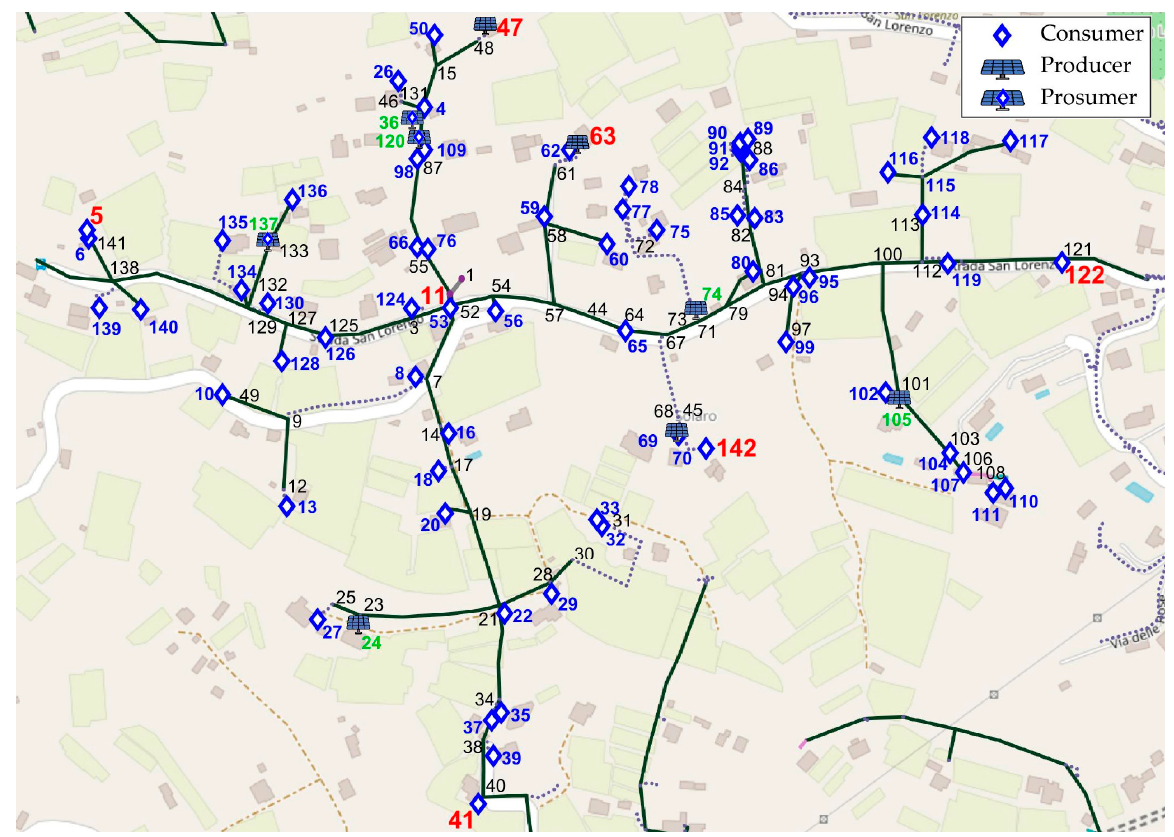
Figure 2. Topology of the observed low ‐ voltage system with indication of the measurement points .